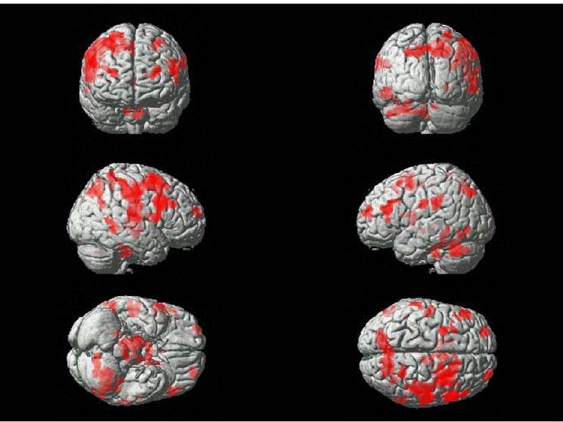
Fig. 1. Between-group differences in brain response to angry facial expression compared to neutral faces. Enhanced brain activations of repressors compared to sensitizers (MNI coordinates). The activations are significant at p , 0.05, k 5 50 (FDR corrected). Reader’s right is subjects’